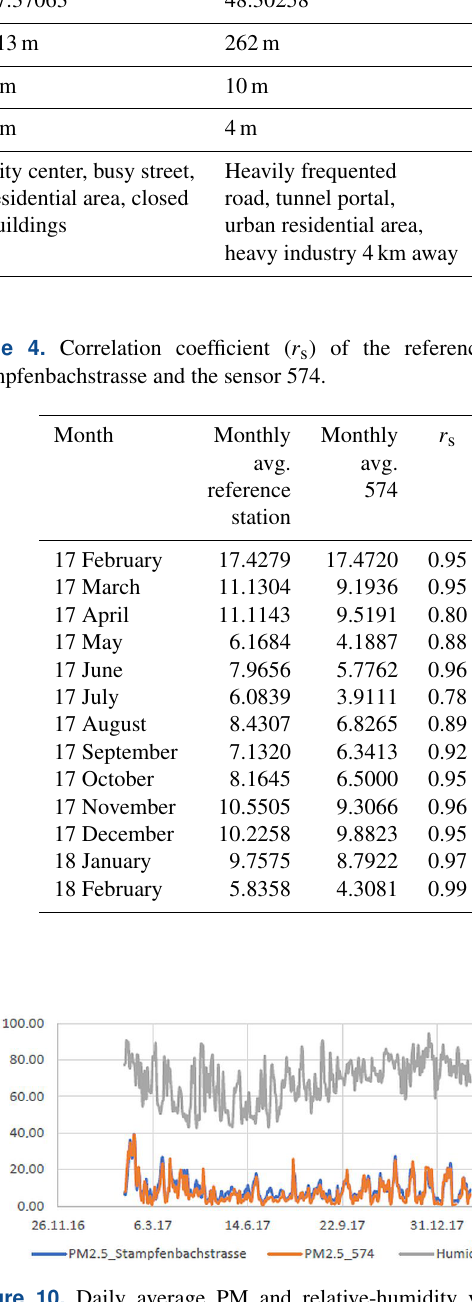
Figure 10. Daily average PM and relative-humidity values for